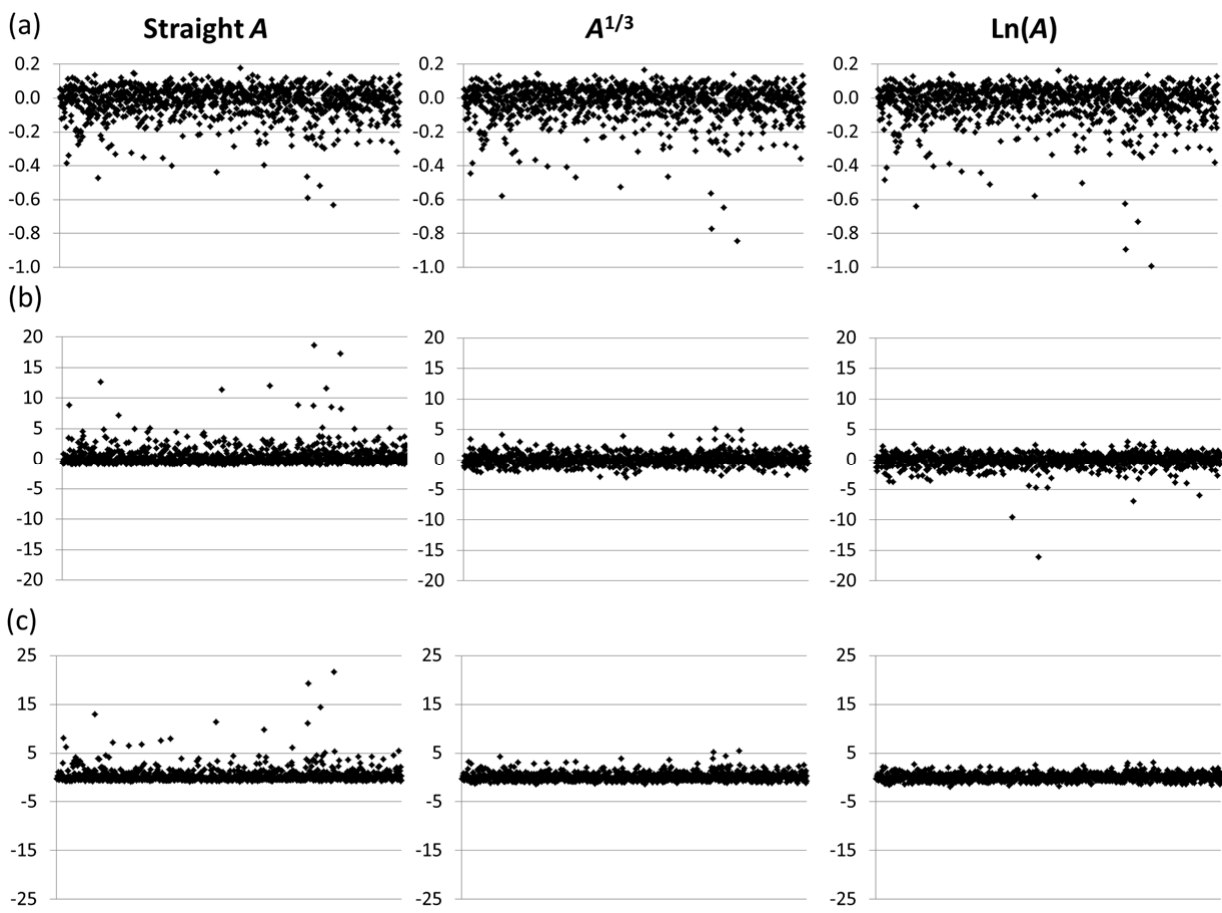
Figure 2. Relative deviations δ f / f of Monte Carlo trial data for three considered transition-rate functions, straight A ( f = A ), power of 1/3 ( f = A 1/3 ), and logarithm ( f = ln( A )) for three typical E1-forbidden transitions within the ground configuration 3d 4 of Fe